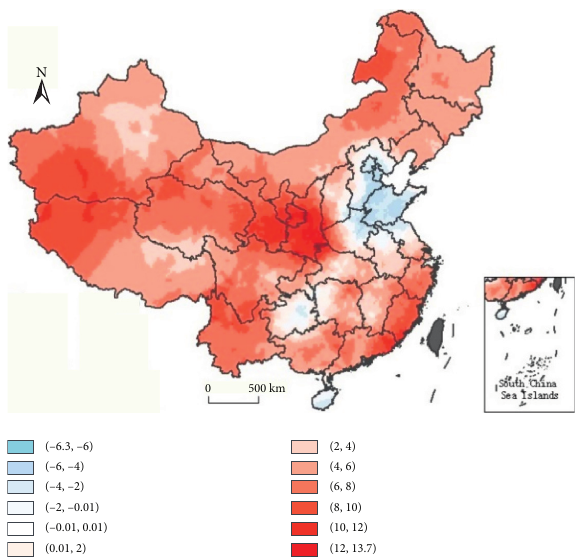
Figure 5: Spatial evolution of the annual average climate comfortable period in China (1981–2010).